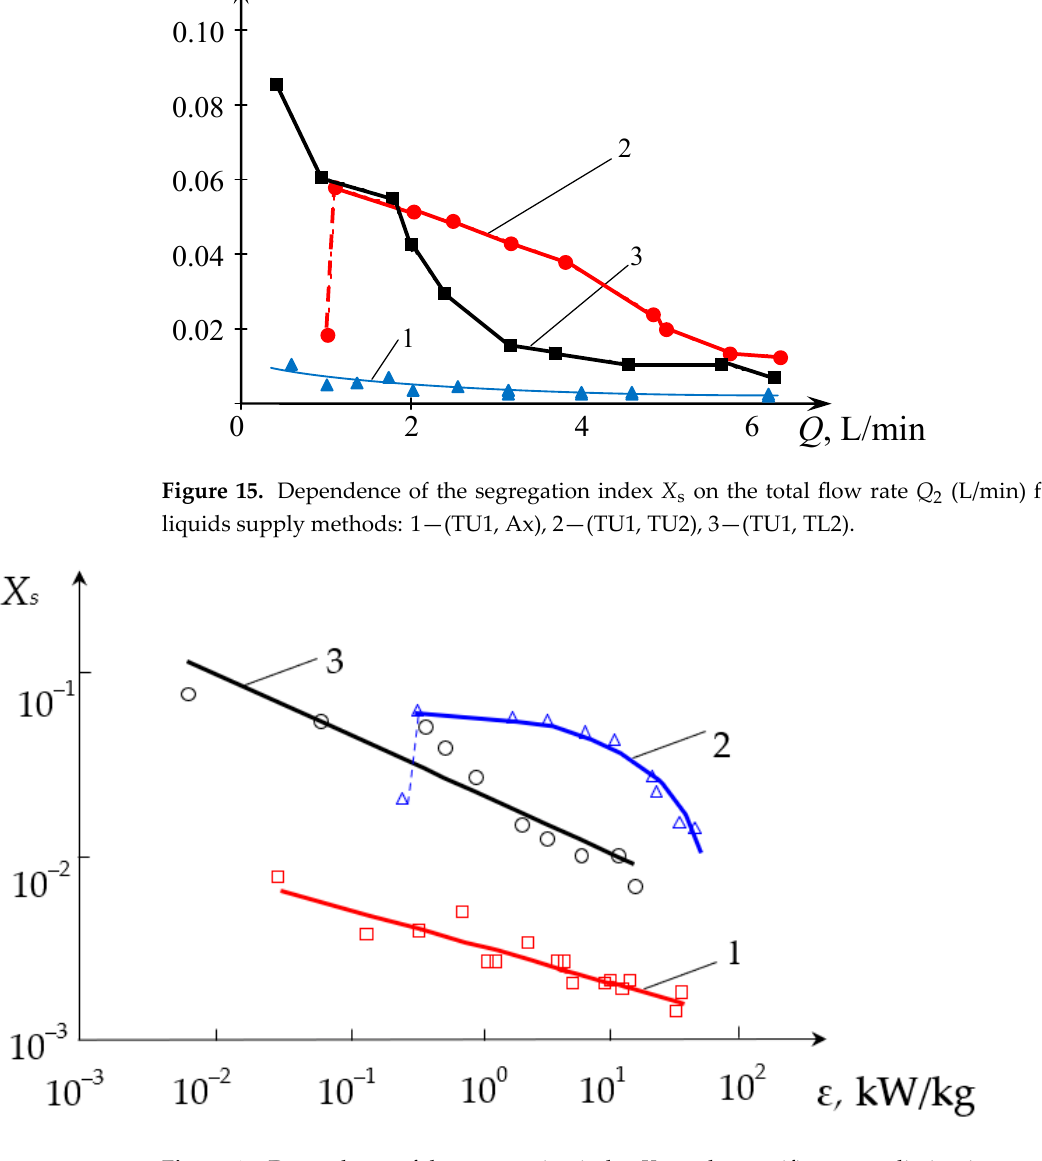
Figure 16. Dependence of the segregation index X s on the specific energy dissipation rate ε (kW/kg)